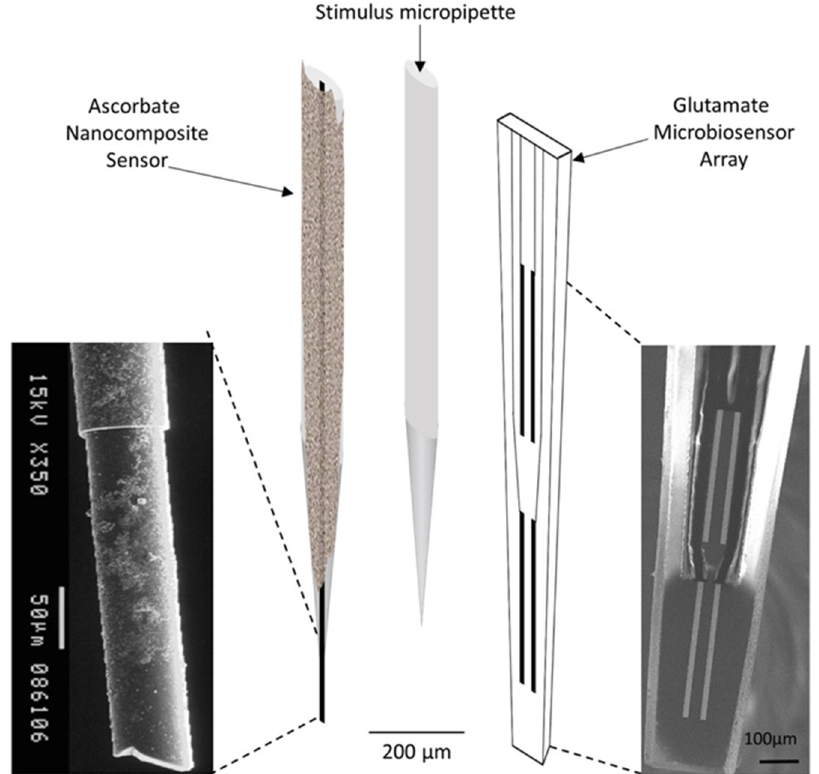
Figure 4. Schematic representation of the array composed by the ascorbate nanocomposite mi- crosensor ( left ), the glutamate microbiosensor ( right ), and the micropipette ( center ) used for local application of solutions in the extracellular space of the rat hippocampus. Reproduced with per- mission from [27]. Copyright 2018 Elsevier.